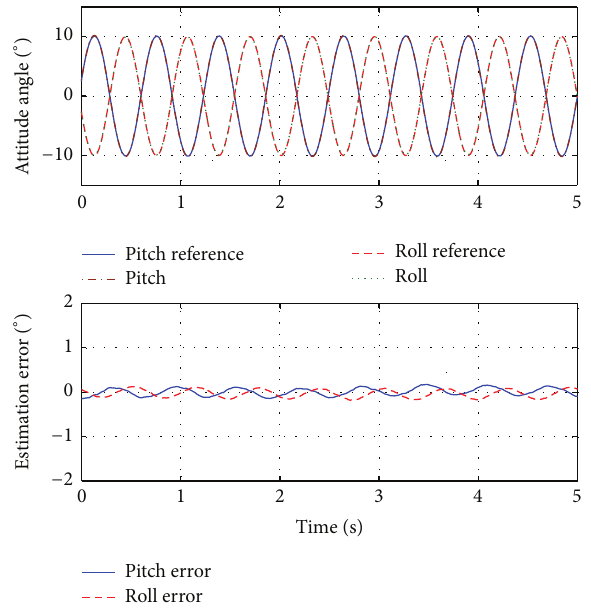
Figure 7: Dynamic performance test of pitch angle and roll angle.